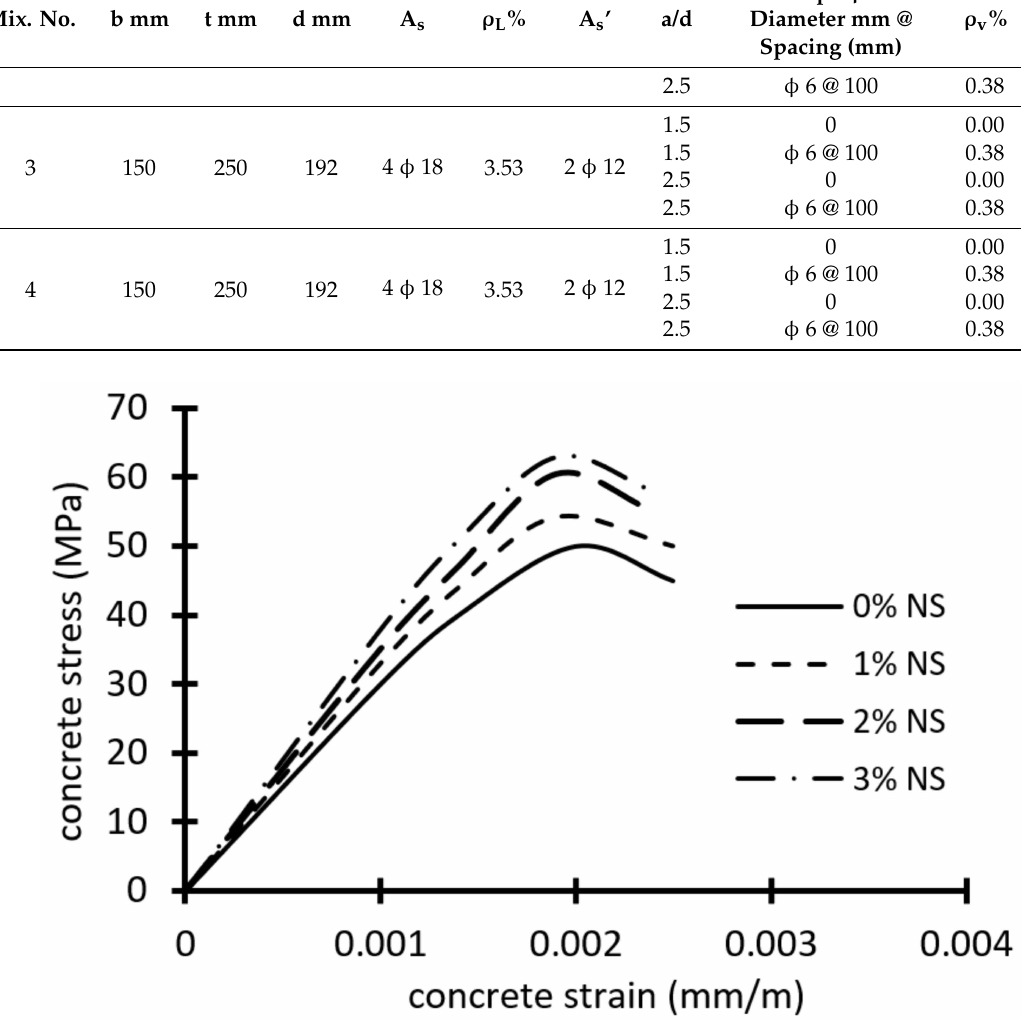
Figure 1. Stress–strain curves for HSC with and without